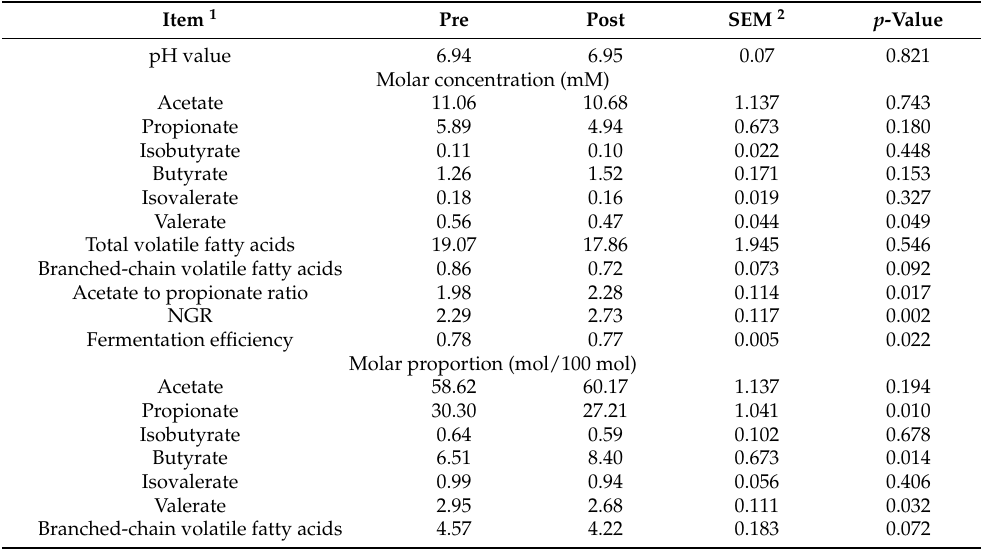
Table 3. Rumen fermentation characteristics before (Pre) and after (Post) diet shift. Item 1 Pre Post